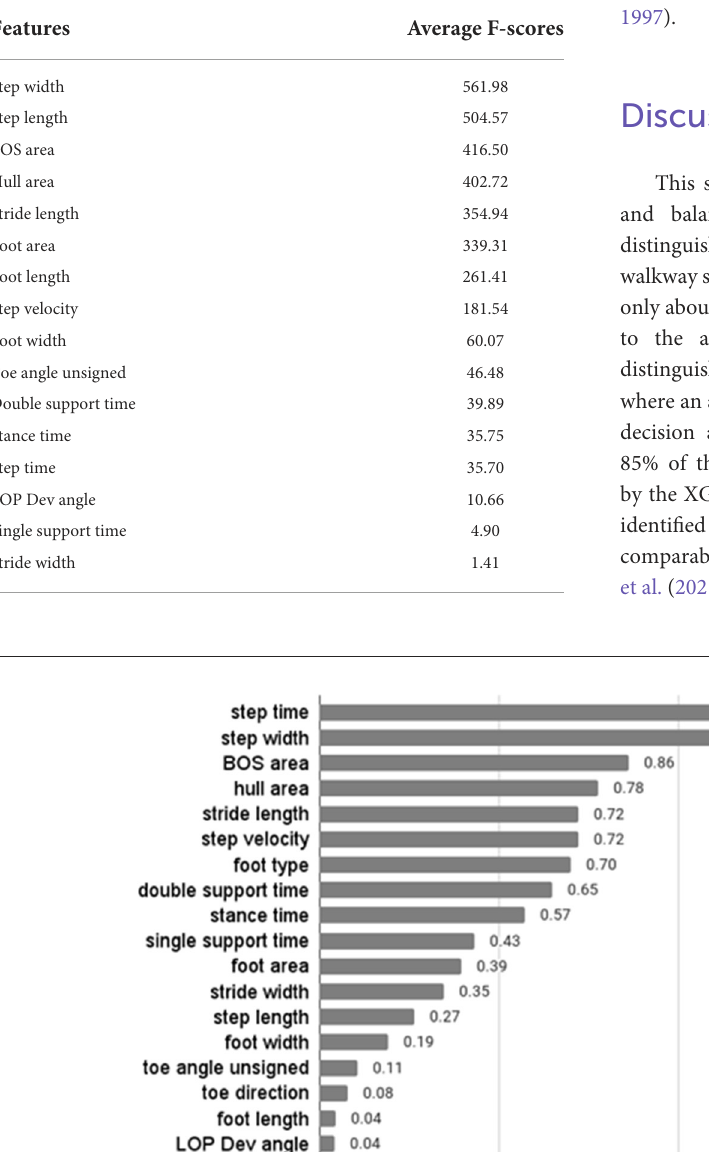
TABLE 3 Average F- score for features.